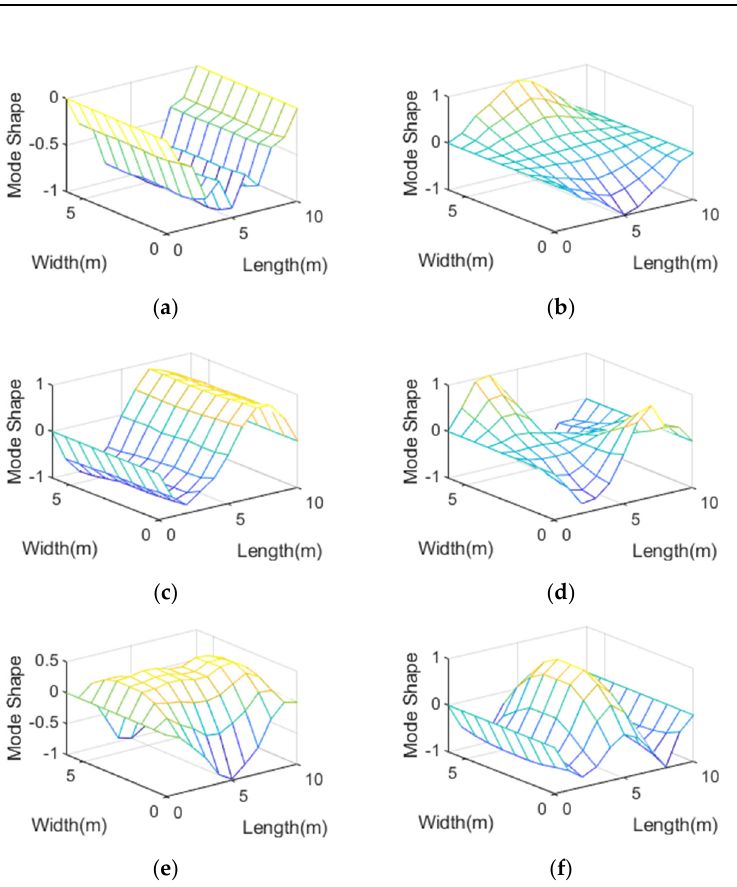
Figure 3. Mode shapes of the structural model: ( a ) Mode 1; ( b ) Mode 2; ( c ) Mode 3; ( d ) Mode 4; ( e ) Mode 5; ( f ) Mode 6.